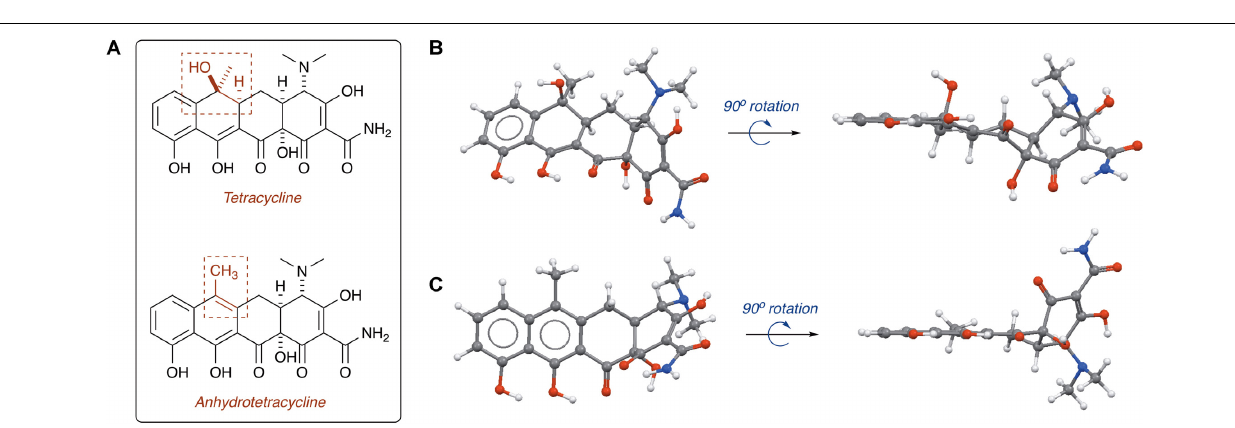
FIGURE 10 | Alternative mechanistic pathway leading to formation of the ring contracted degradation product ([M+H] + 467.1216) initiated by hydroxylation of C2.